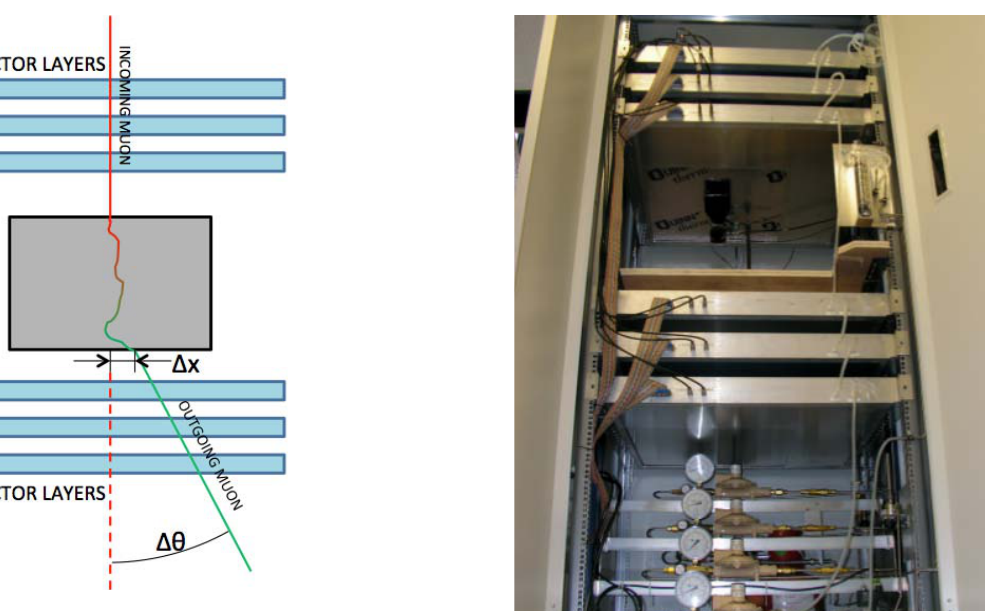
Fig. 1. Muon scattering tomography principle. The muon passes through the upper detectors, scatters in the target, and leaves via the lower detectors. The measured scatter angle allows for estimation of the target Z .